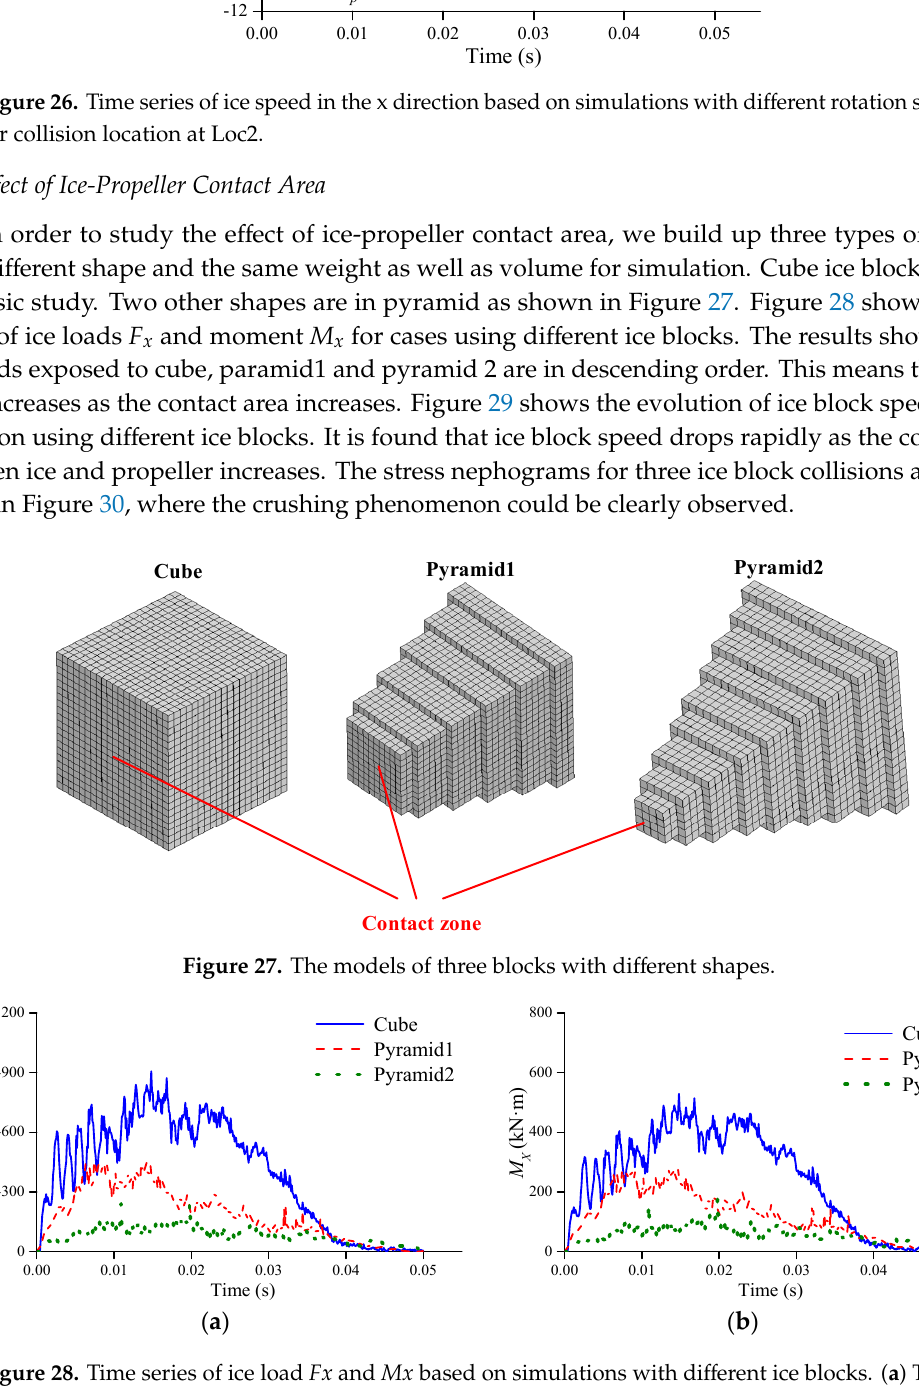
(c) Figure 30. Stress nephograms of simulations for ice blocks with different shapes. (a) Impact simulation with cube ice block. (b) Impact simulation with pyramid1 ice block. (c) Impact simulation with pyramid2 ice block. 7. Conclusions In this paper, a numerical tool based on cohesive element method is applied to simulate an ice-propeller collision process with the assistance of commercial finite element software LS-DYNA. The convergence study with respect to the meshing size of the ice block is conducted. Then, the